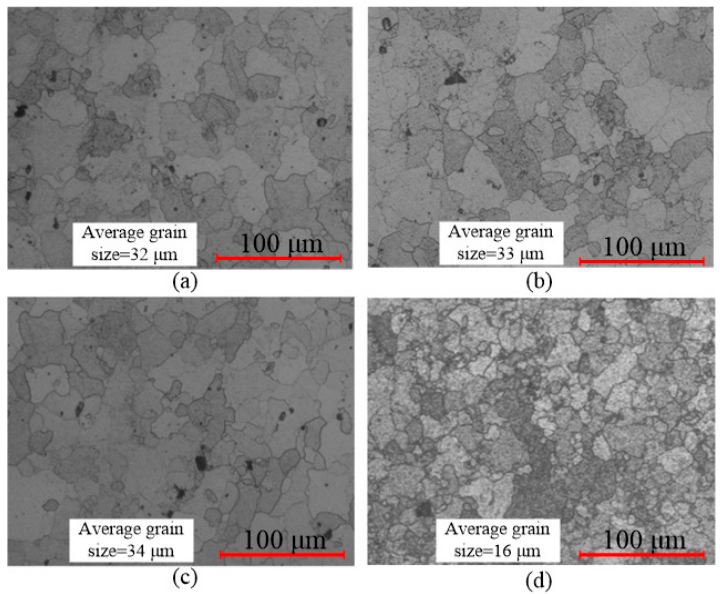
Figure 17. Grain distribution in sheet metal with different forming temperatures: ( a ) 25 °C; ( b ) 200 °C; ( c ) 300 °C; ( d ) 400 °C.